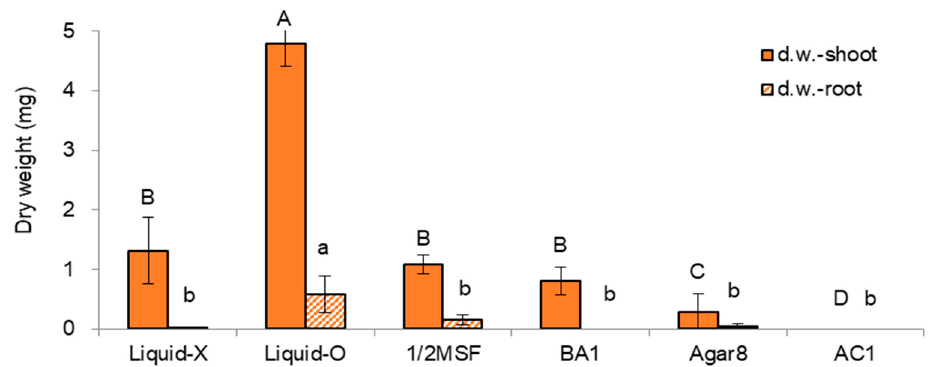
Figure 2. Dry weight (mg) of in vitro grown P. yatabeanus plantlets with six treatments of subculture medium and supplements for five weeks. Liquid-X: MSF, gellan gum 3.0 g L − 1 , Liquid-X; Liquid-O: MSF, gellan gum 3.0 g L − 1 , Liquid-O; 1/2MSF: half-strength MSF, gellan gum 3.0 g L − 1 , Liquid-X; BA1: MSF, gellan gum 3.0 g L − 1 , Liquid-X, benzyl adenine (BA) 1 mg L − 1 ; Agar8: MSF, agar 8.0 g L − 1 ,